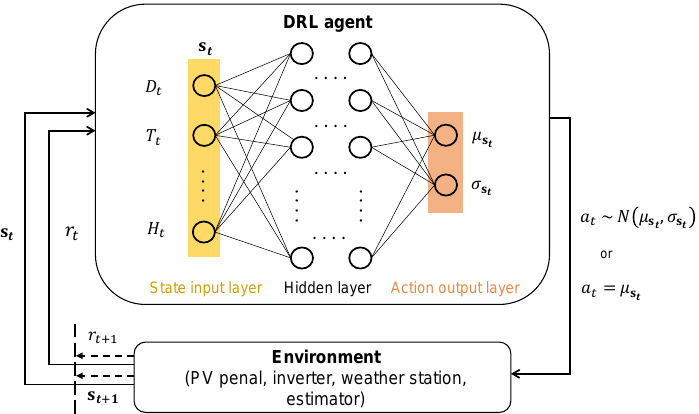
Figure 8. DRL structure for setting dynamic